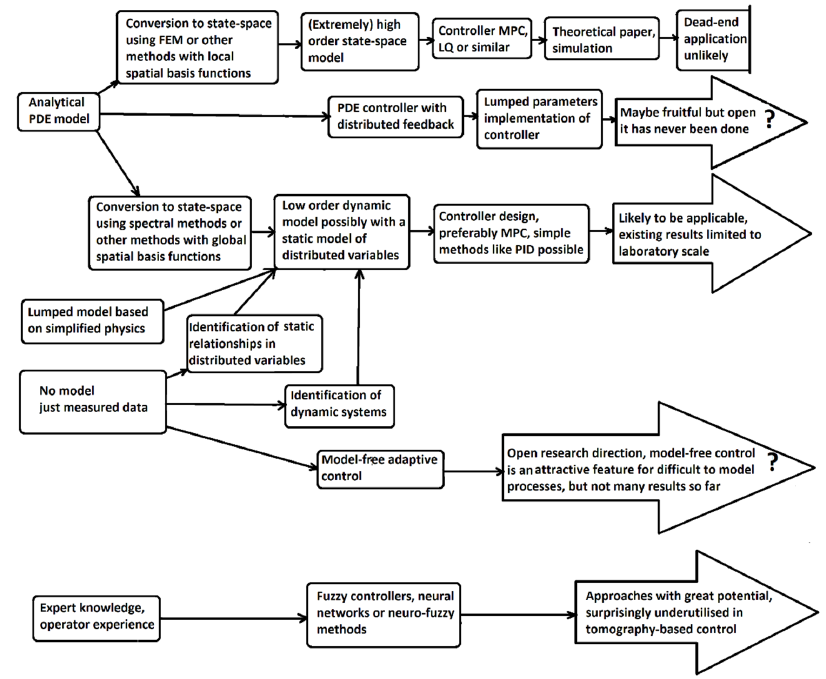
Figure 12 . Potential of modelling and control approaches for tomography-based control. Figure 12. Potential of modelling and control approaches for tomography-based